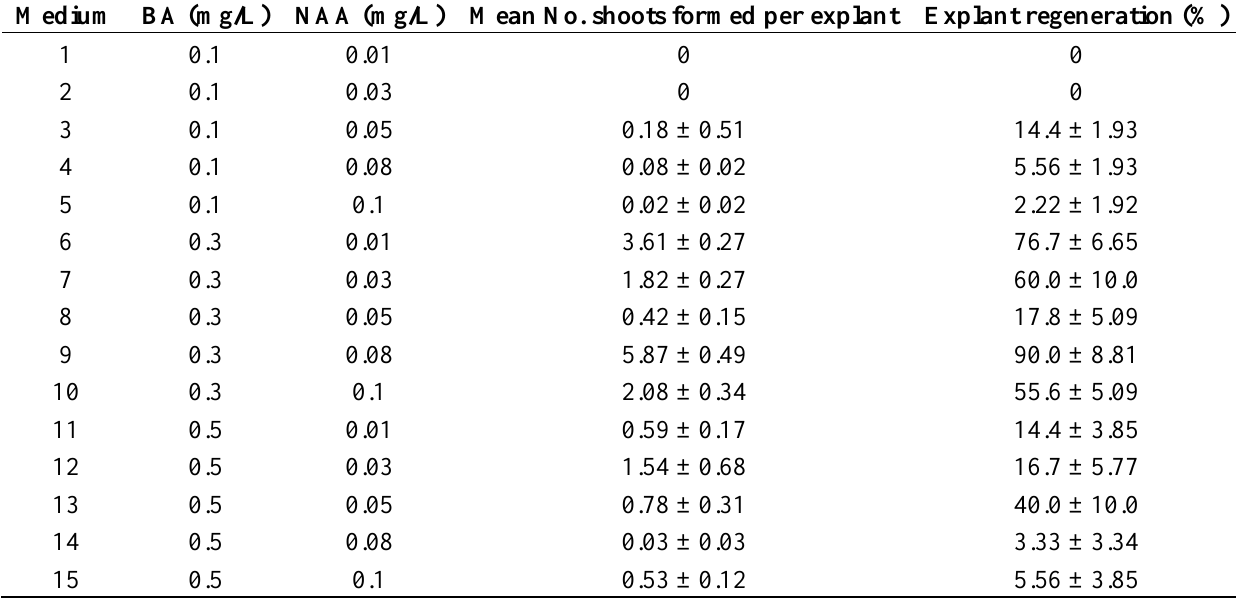
1. Effect of BA and NAA on shoot regeneration of leaf explants of Populus davidiana Dode × Populus bollena